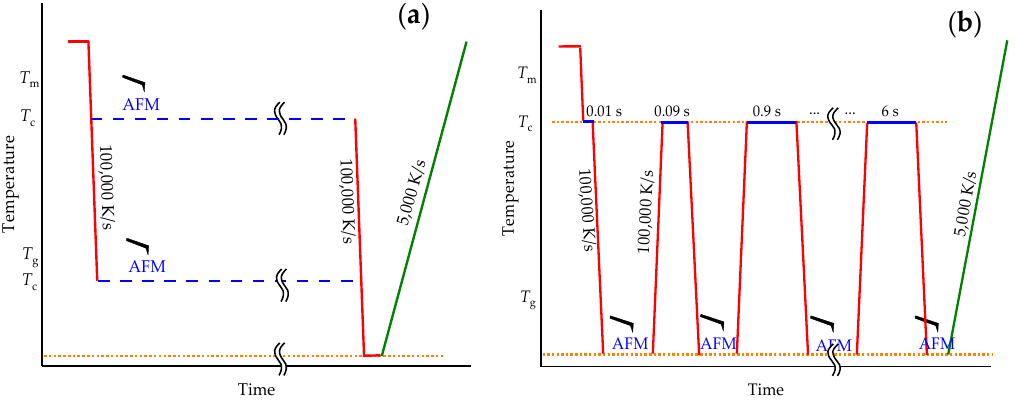
Figure 4. Program for studying isothermal crystallization by AFM-FSC combination. ( a )—taking AFM images during slow crystallization at a temperature either close to T 0 m or, using quenching, close to T g . ( b )—time-resolved imaging, using ultra-fast cooling and heating ability of FSC. In both cases, the final FSC heating scan after crystallization is taken at 5000 K / s starting at ambient temperature.